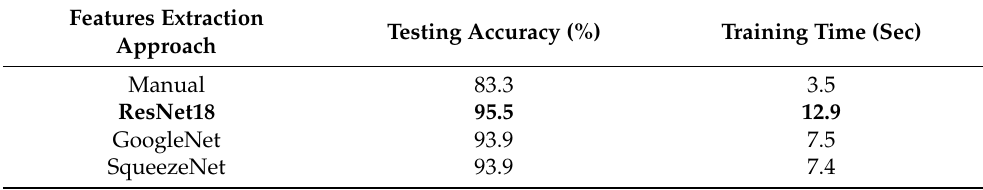
Table 8. SVM testing accuracy and training time using different features extraction